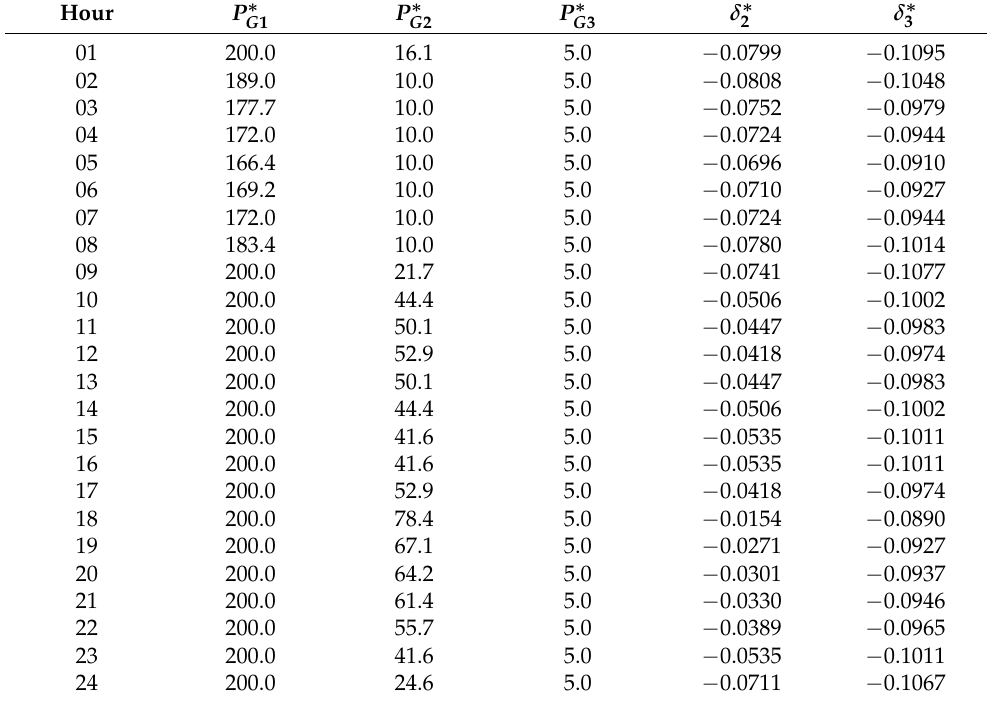
Table 4. Three-bus example, DC-OPF